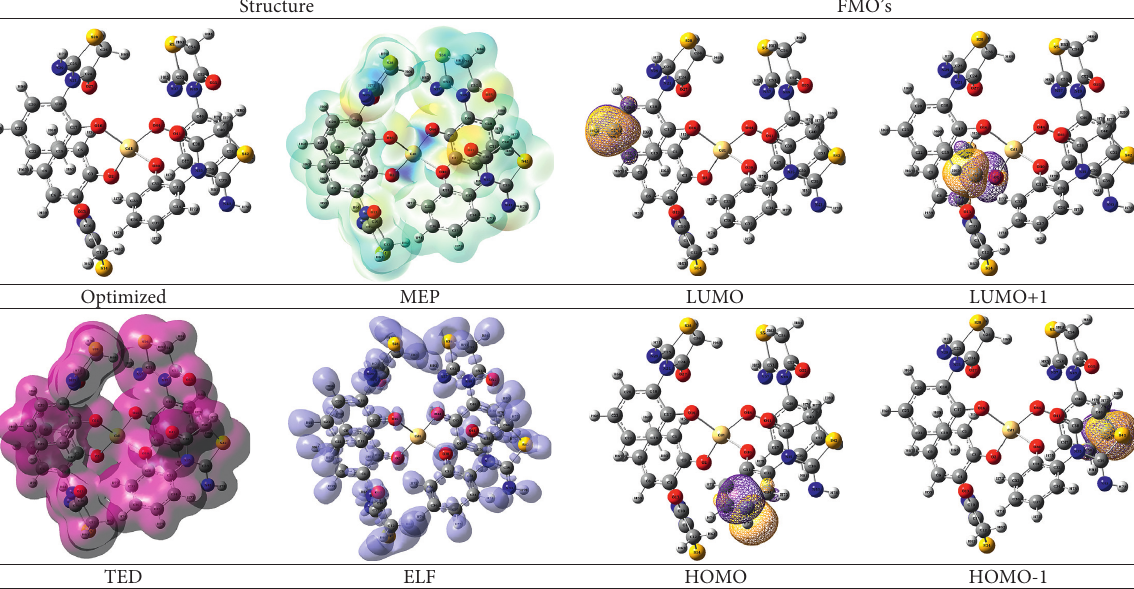
Figure 5: Optimized structure, FMOs, surfaces, and ELF plots of